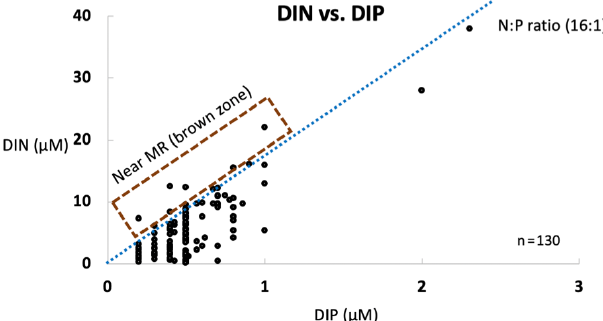
Figure 9. Dissolved inorganic nitrogen (DIN) against dissolved in- organic phosphorus (DIP) during sampling periods in GOM and mid-western CSK. Nearly all samples had an N : P ratio of <16, which indicated potential N-limited conditions. At a few points near the brown zone the ratio was between 16 and 18; this is where light limitation is expected according to